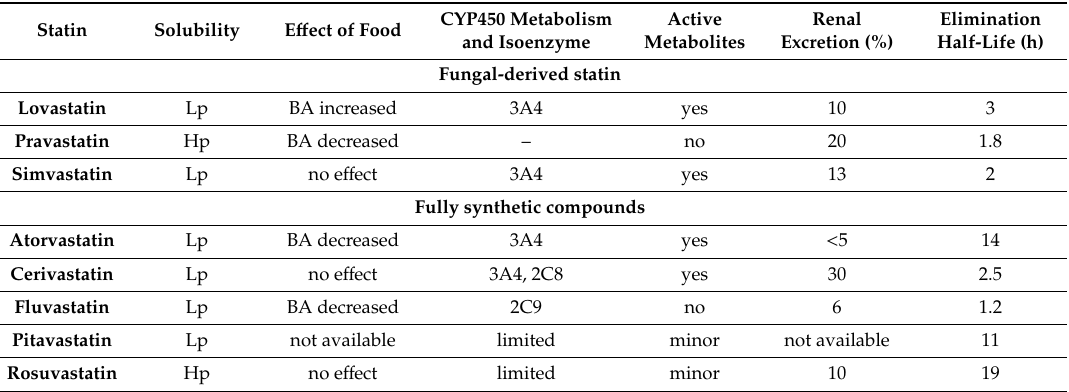
Table 2. Pharmacokinetic properties of statins